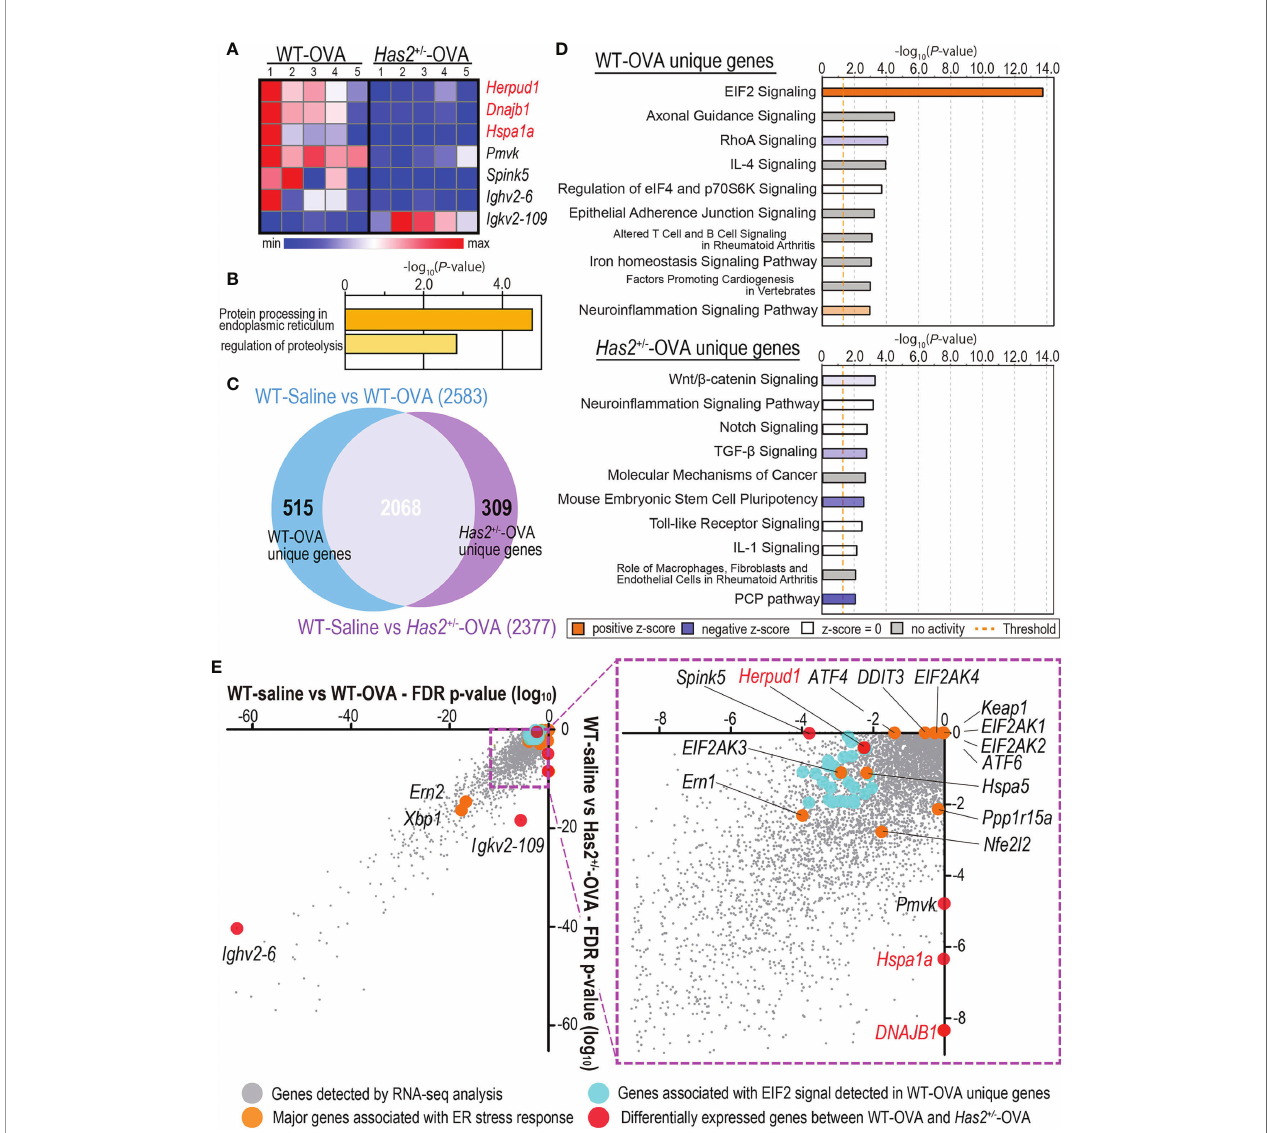
FIGURE 4 | DEG analysis between the lungs from WT-saline, WT-OVA, and Has2 +/ − -OVA mice. (A) Heatmap of DEGs between the lungs of WT-OVA and Has2 +/ − -OVA mice ( n = 5, cutoff: adjusted P < 0.01; log 2 fold change > 1.2). Hierarchical clustering was performed based on the mean log 2 fold change. Gene symbols in red are associated with endoplasmic reticulum stress response. (B) Signi fi cant biological process terms detected by GO analysis from WT-OVA and Has2 +/ − -OVA mice. (C) Identi fi cation of the unique DEGs between WT-saline vs. WT-OVA and WT-saline vs. Has2 +/ − -OVA using the Venn diagram. (D) Top 10 signi fi cant terms detected by pathway analysis in WT-OVA unique (upper panel) and Has2 +/ − -OVA unique genes (lower panel). (E) DEG P -value correlation plot between WT-saline vs. WT-OVA and WT-saline vs. Has2 +/ − -OVA. DEGs, differentially expressed